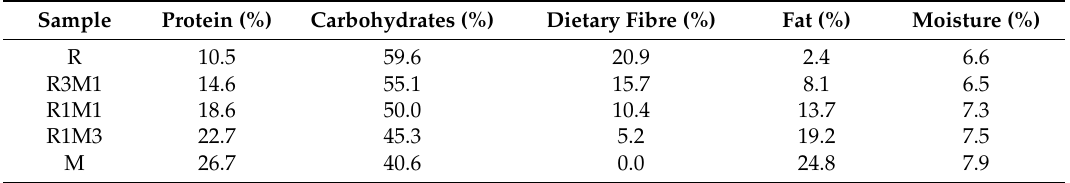
Table 7. Approximate composition (%) of 3D printed 5-layer samples after baking (calculated based on average dry matter content and raw material composition given by